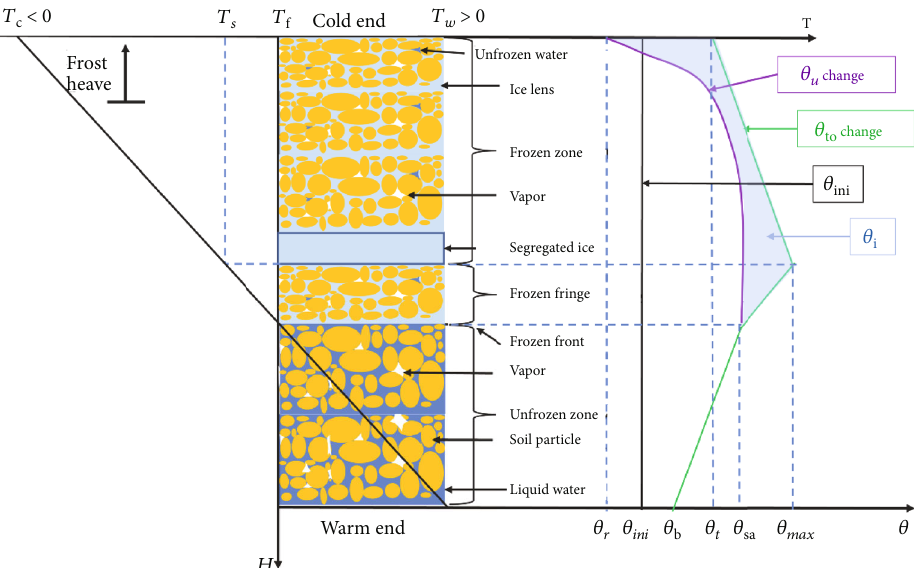
Figure 18: Schematic of soil column segregation frost